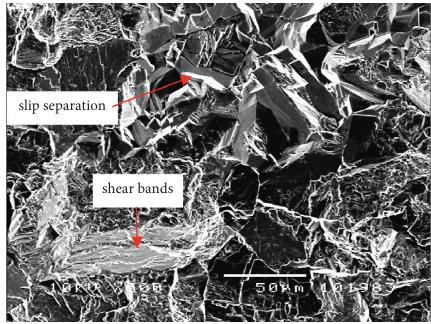
Figure 23: Local microscopic fracture morphology for marble.